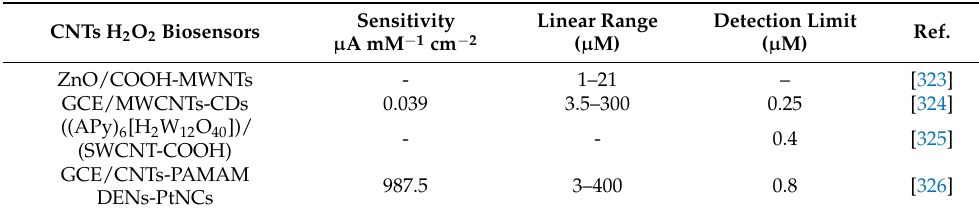
Table 5. CNTs-supported metal nanoparticles biosensors for electrochemical sensing of H 2 O 2 secreted from cancerous